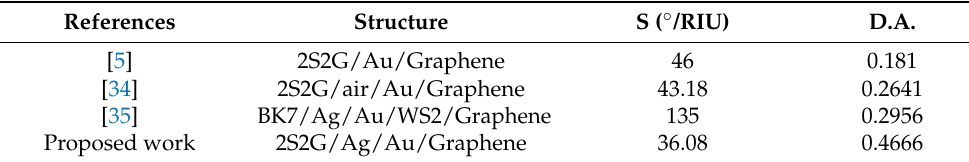
Table 4. Comparison performance among the proposed sensor with that of other reported sensors.